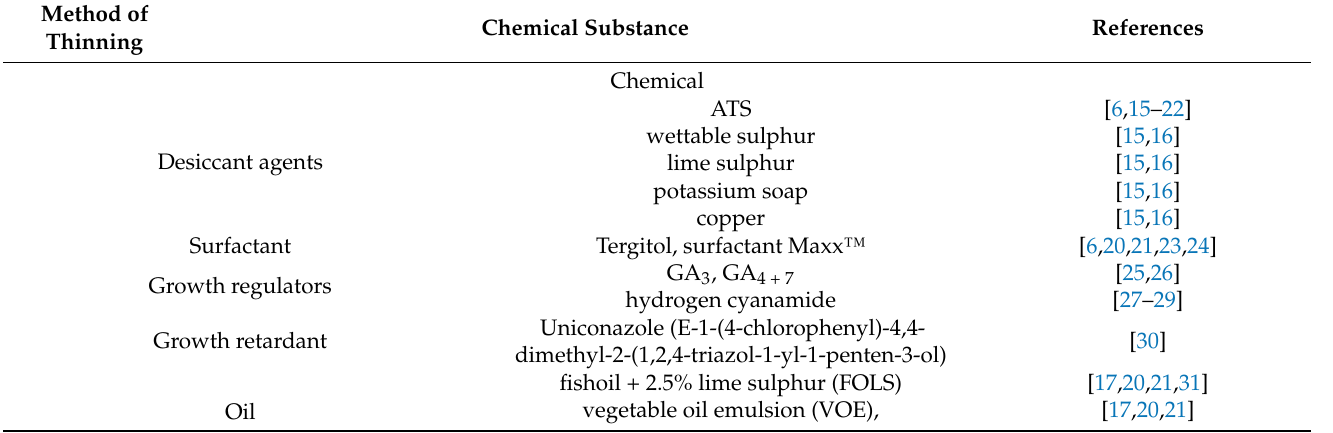
Table 1. Summary of experimental methods of thinning sweet